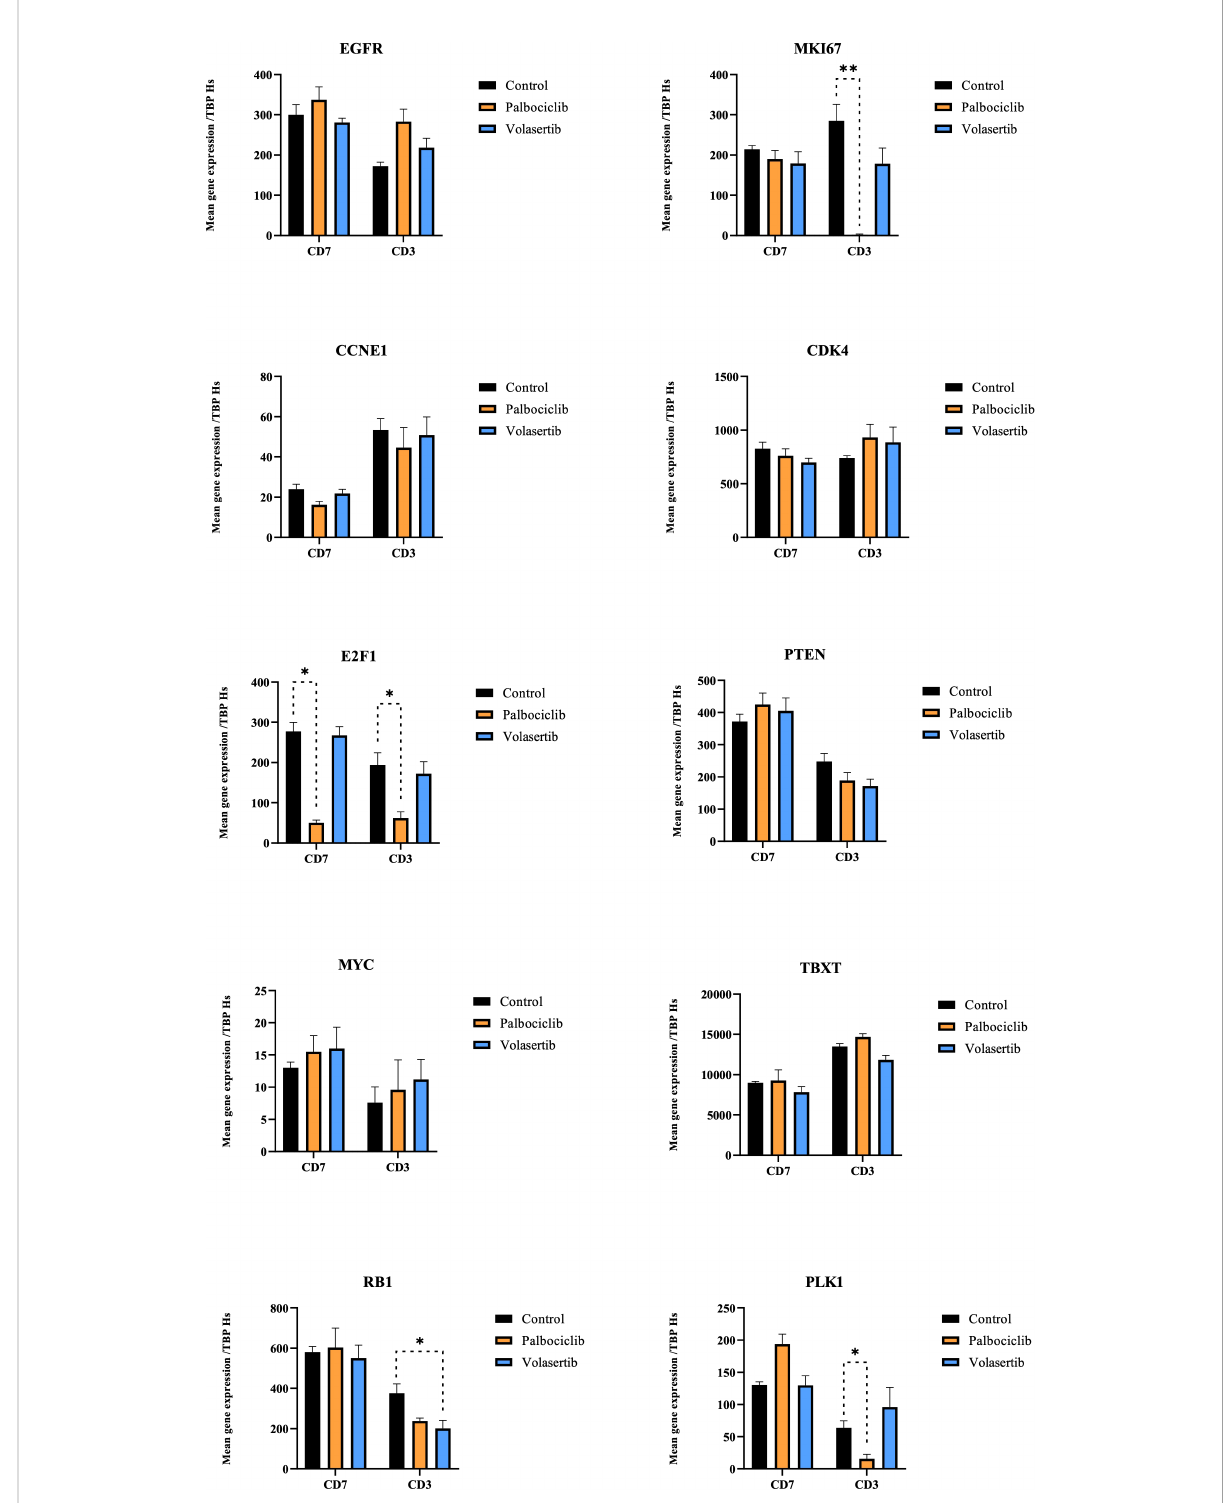
FIGURE 4 Gene expression modi fi cations after treatments with palbociclib and volasertib (CD3 and CD7 models). Quantitative RT-PCR was performed to measure the expression of the target genes. Data are presented as level of gene expression compared to the standard level of Homo sapien (Hs) TBP. Genes expressions were compared between mice treated with the indicated agent and the control group. Error bars show the standard error of the mean. * and ** achieve statistical signi fi cance compared to control (p < 0.05 and p < 0.01, respectively) by Mann – Whitney U